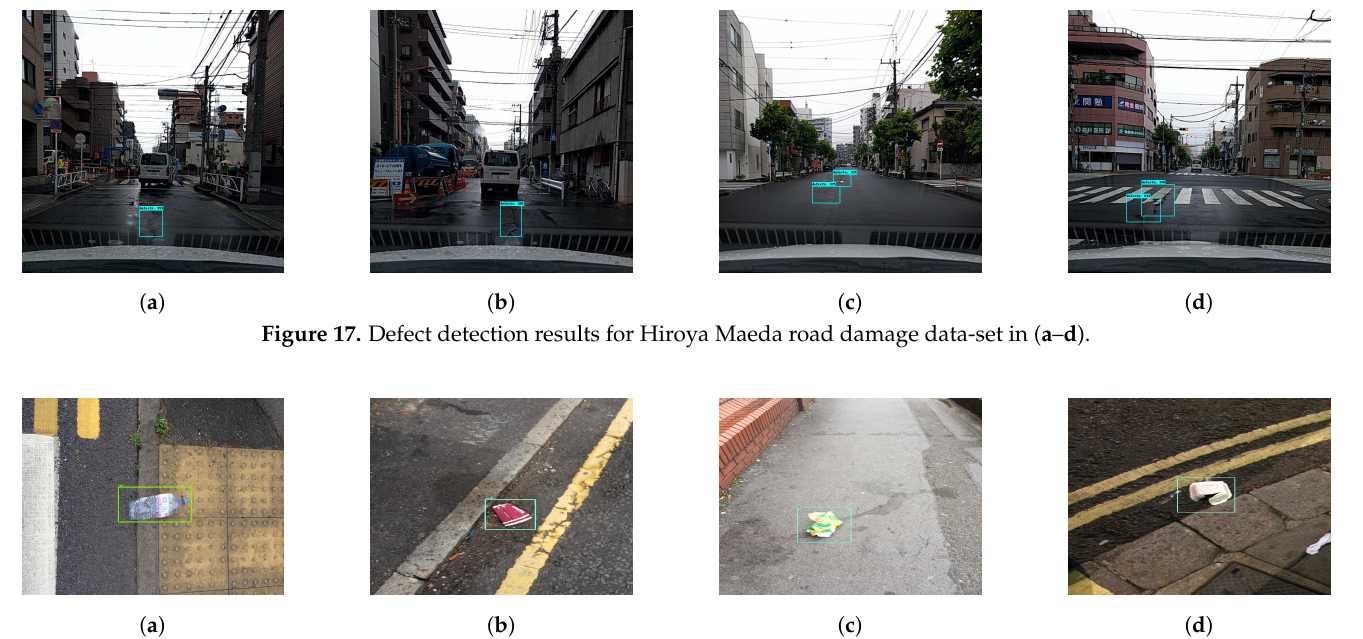
Figure 18. Garbage detection results for Taco trash image dataset in ( a – d ).